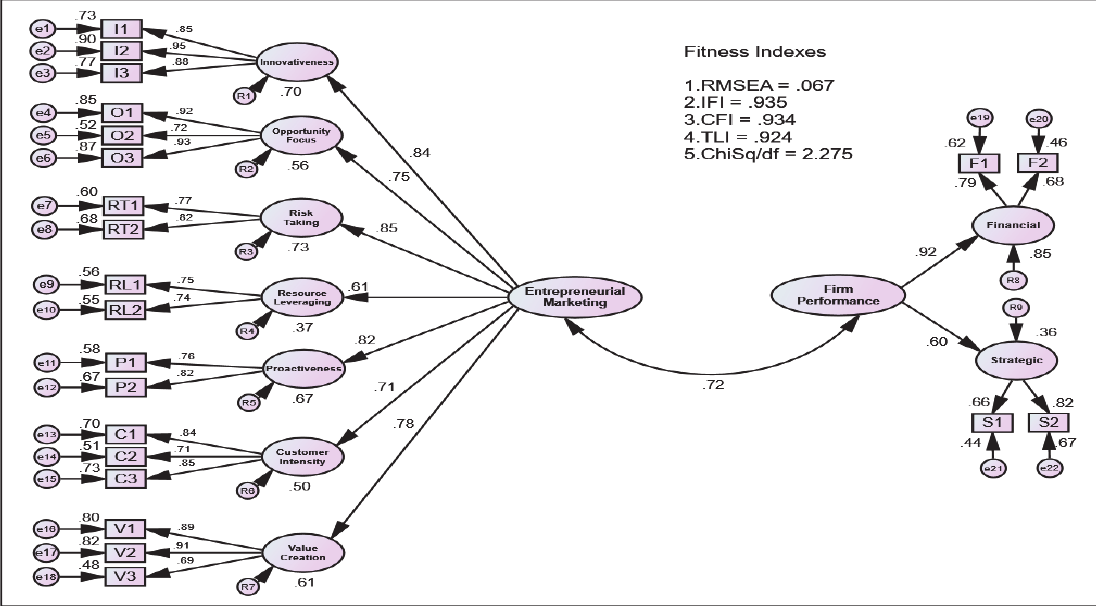
Fig. 2. Measurement Model with Fitness Indexes